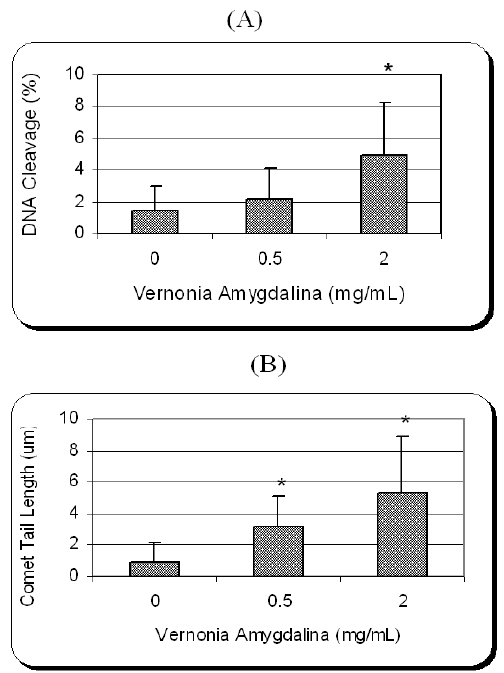
Figure 3 : Comet assay of MCF-7 cells showing the percentage of DNA cleavage (Left) and tail length (Right), as a function of VA leaf extracts doses. Each point represents mean ± SD of 3 independent experiments. *Significantly different ( p < 0.05) from the control, according to the Dunnett’s